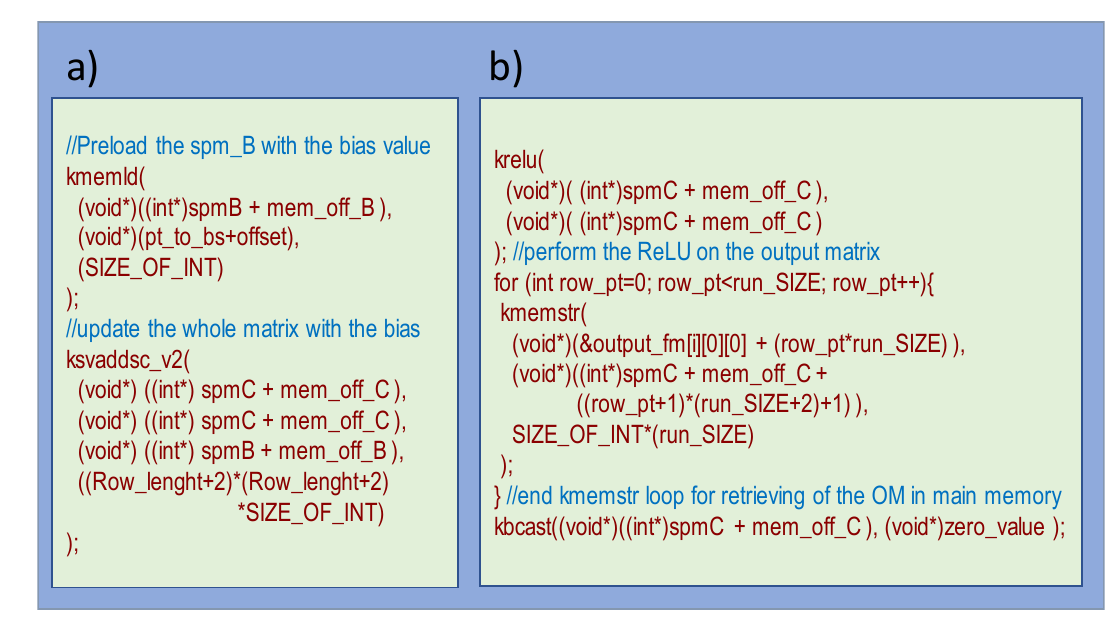
13 of 22 Figure 11. Convolution2D inner loops operations (Layers: 1, 2, 4, 5, 7, 8, 9, 11, 12, 13, 15, 16, 17). Referring to Figure 11, after setting the vector length, the loop with index “ i ” scans the rows of the output matrix (OM); the FM_row_pointer loop and the column_offset loop iterates three times each to cover the necessary vector-scalar product required for the 3 × 3 kernel matrix. The FM_offset variable points to the proper FM row in spmA, from which